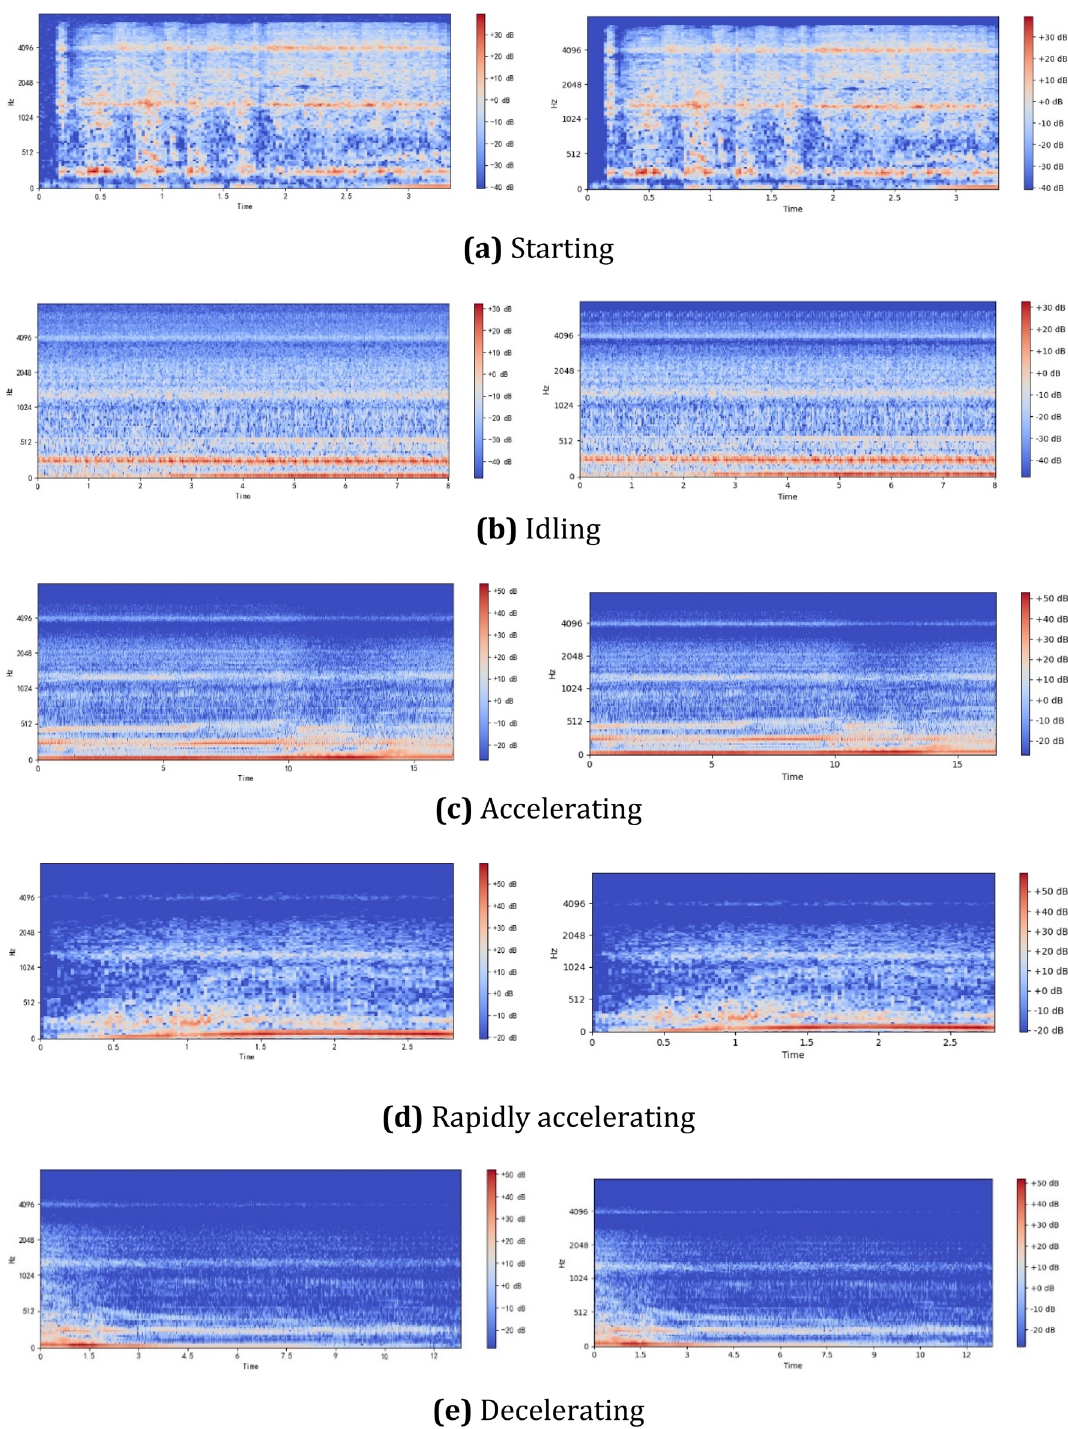
Figure 1. Logarithmic Mel spectrogram of engine sound with different signal-to-noise rations (SNRs) under five typical engine operating operating condition. The energy is concentrated at certain regions where the color is bright, but the color fades into dark gray toward the boundary, where the edge becomes irregular. This indicates that the energy decay of frequency components occurs at varying rates. In addition, the length of the time window and the size of the sliding step can affect the conversion from engine sound to logarithmic Mel spectrogram, but because the time window is small and the sliding distance short, the differences in the Mel spectrogram are small.